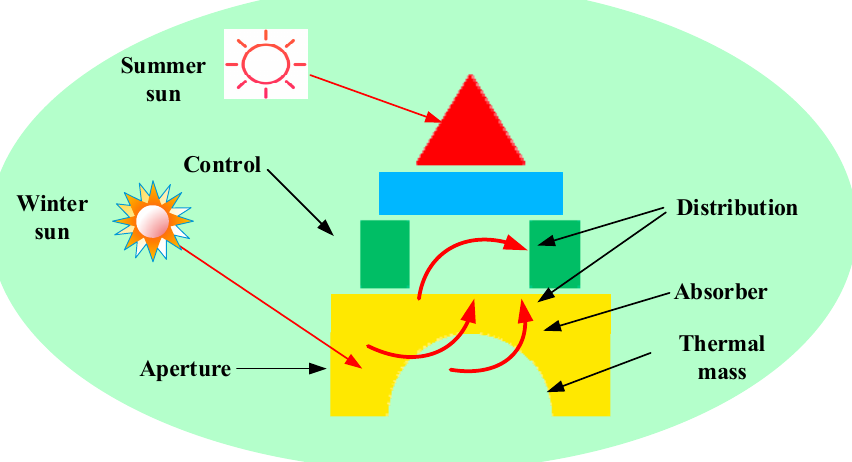
Figure 2. Design elements of passive solar buildings (Source: the authors).